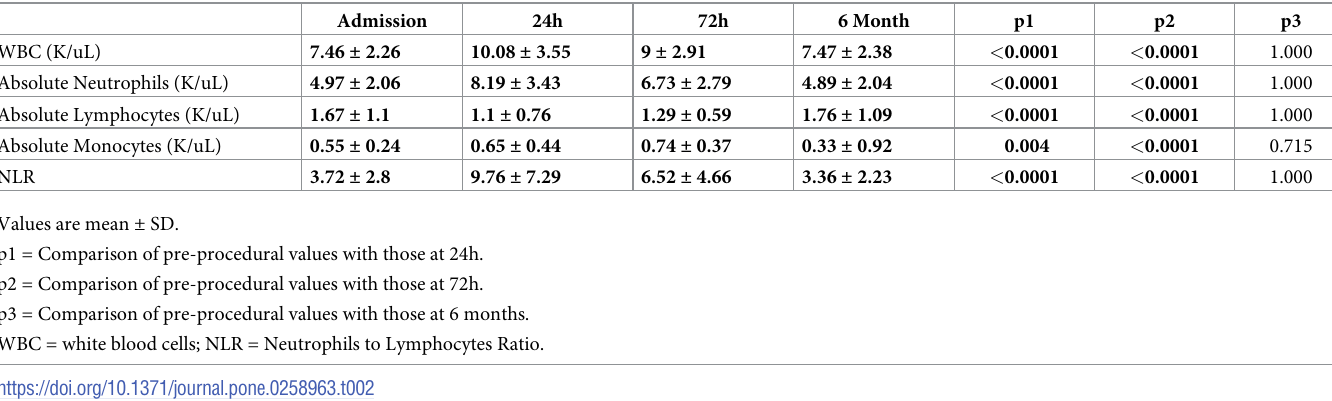
Table 2. Dynamic changes of WBC and their subpopulation after TAVI.